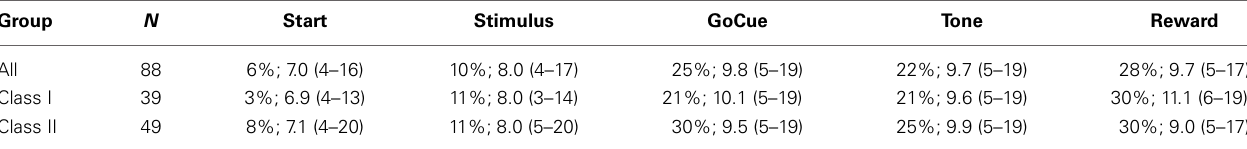
( Figure 1D ) demonstrated that the animals’ performance started near chance (25%) and reached approximately 80% after